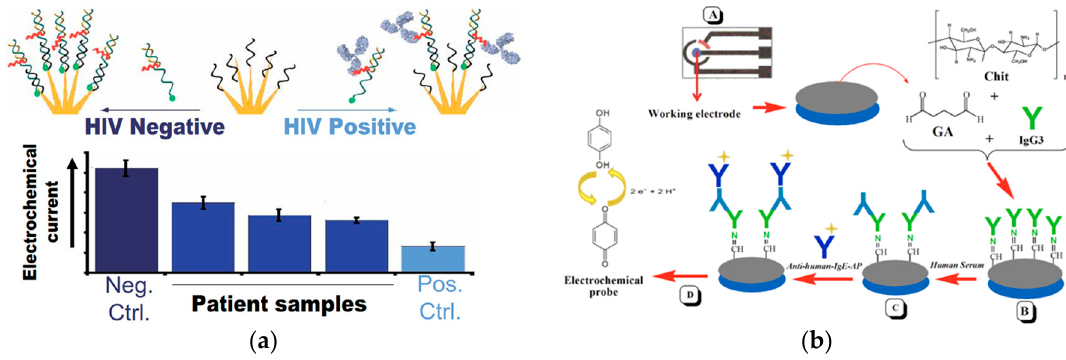
Figure 5. ( a ) With the presence of target antibodies, the hybridization of the redox-labeled PNA- peptide complex to the capture DNA bound to the electrode is reduced; the current signal is measured with the presence (black line) or absence (blue line) of the target antibodies (adapted with permission from Ref. [50] Copyright 2019 American Chemical Society). ( b ) Schematic of the electrochemical sensor for detection of IgE. Carbon or gold electrode (A) is covered with a chitosan film through combination of glutaraldehyde and hoIgG3 (B). Test serum is added to capture human IgE (C), and goat anti-IgE labeled with alkaline phosphatase is added to enable the reaction with hydroquinone (D). (Adapted from Ref. [51]. Copyright © 2017 Elsevier B.V.)